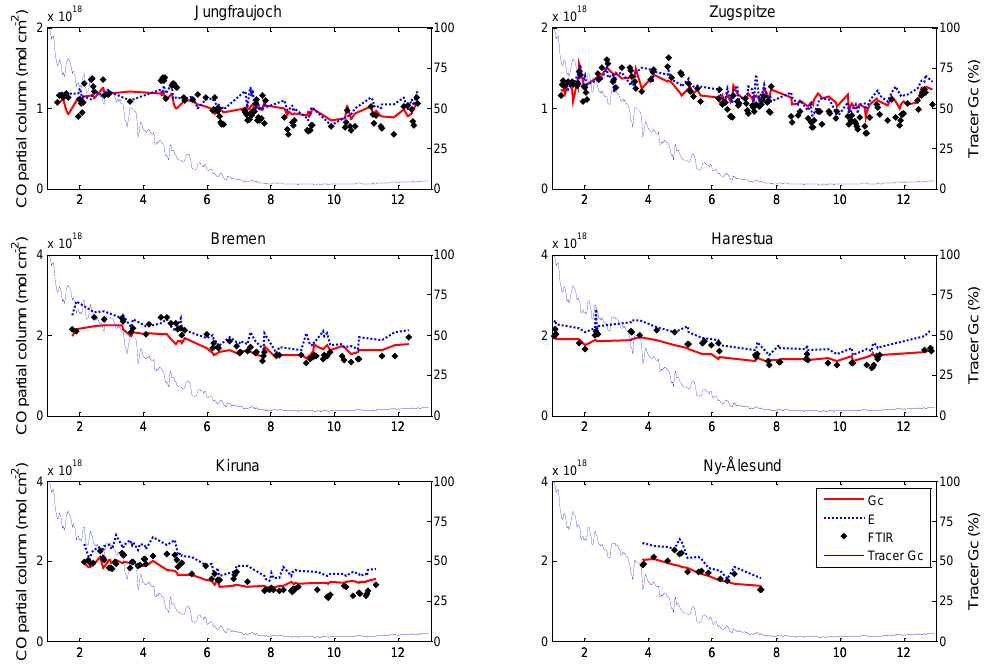
Figure 3. CO partial columns of 2006 derived from the global (Gc) and European-scale (E) model. The FTIR and tracer calculations for the Gc model is also shown. The x-axis presents months where zero refers to the 1 st of January. The first months are highly influenced by the model initial conditions which corresponds well to the CO and C 2 H 6 lifetimes of 2-3 months (Finlayson-Pitts and Pitts, 2000).